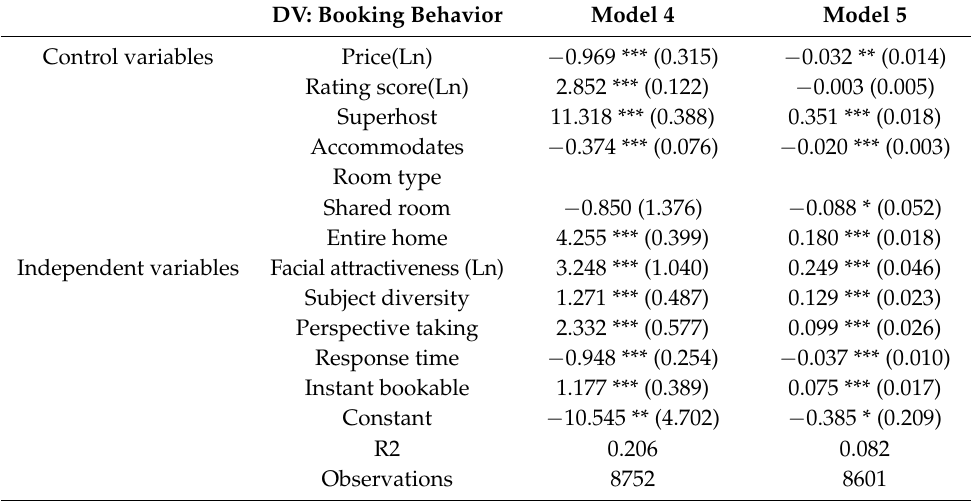
Table 6. Results of robustness